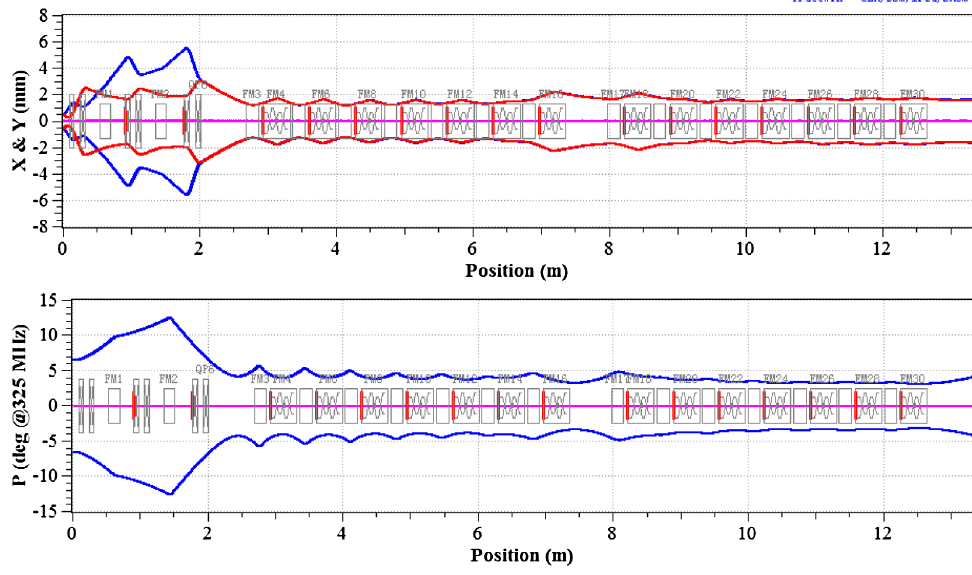
FIG. 15. The RMS envelope evolution of the Injector I SC section integrated with MEBT1.